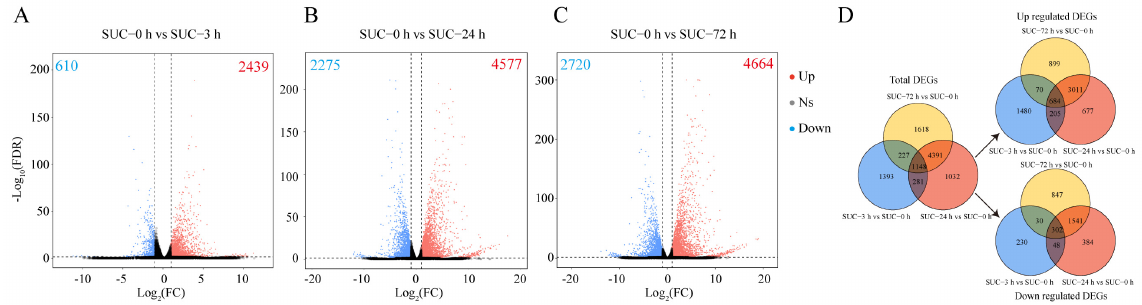
Figure 3 . Analysis of DEGs in different groups. ( A ) Volcano plot of DEGs in response to sucrose treatment for 0 h vs. 3 h. ( B ) Volcano plot of DEGs in response to sucrose treatment for 0 h vs. 24 h. ( C ) Volcano plot of DEGs in response to sucrose treatment for 0 h vs. 72 h. ( D ) Venn diagram of the DEGs in different groups under sucrose treatment. Red dots indicate upregulated genes, and blue dots indicate downregulated genes. Gray dots indicate no significant differentially expressed genes. Ns, no significant difference. The numbers of upregulated and downregulated DEGs are shown in the corresponding figures.